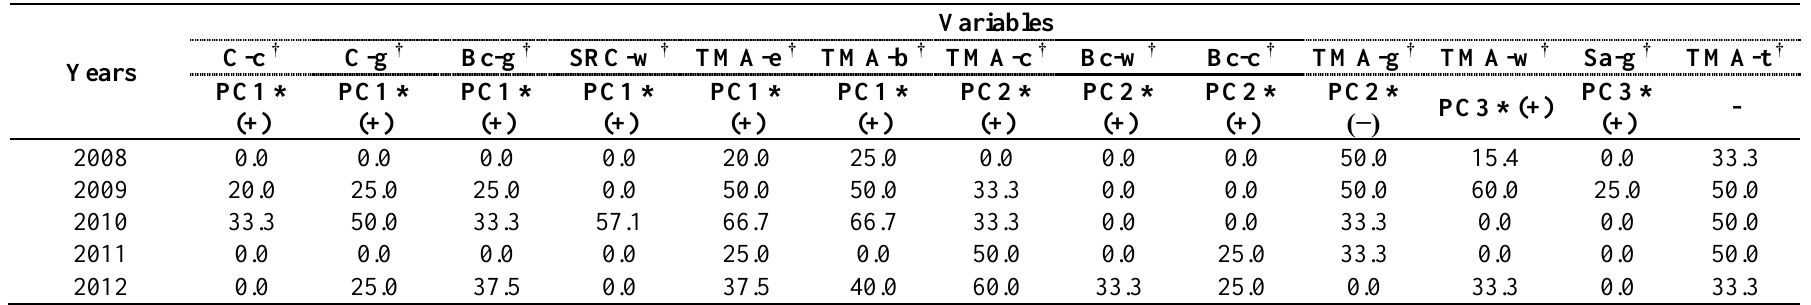
Table 5. Frequency of non-conforming samples detected in 2008–2012 for each of the 13 microbiological variables used for the PCA. The variables are grouped based on their relative importance within each principal component. The sign of the eigenvector coefficient for each variable is also